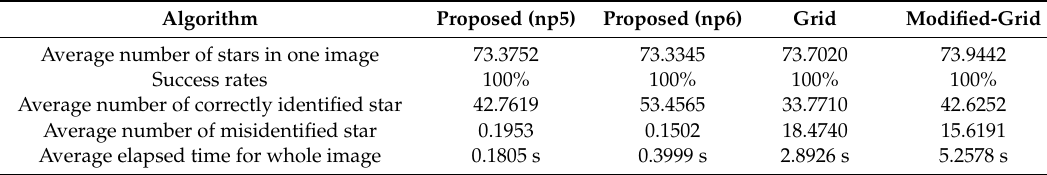
Table 11. Case 3-2: Comparing results of star identification methods in 23.98 ◦ × 23.98 ◦